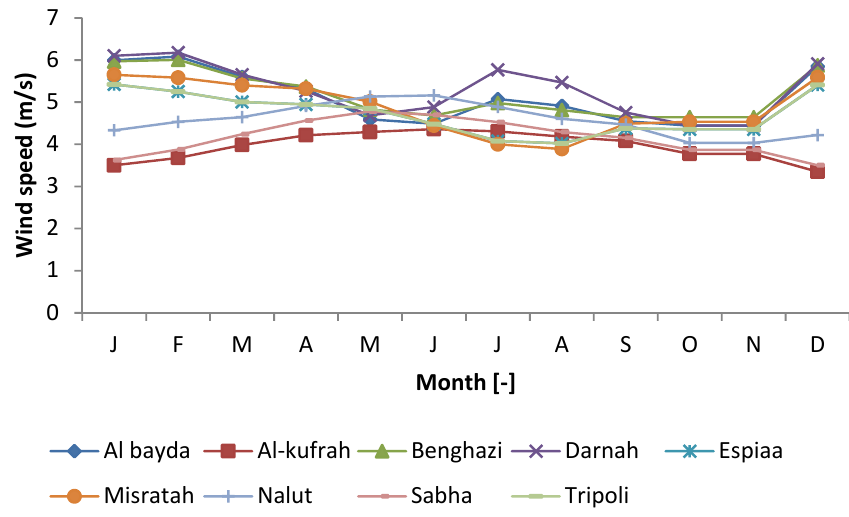
Figure 4. NASA mean monthly wind speed for all selected regions in Libya.